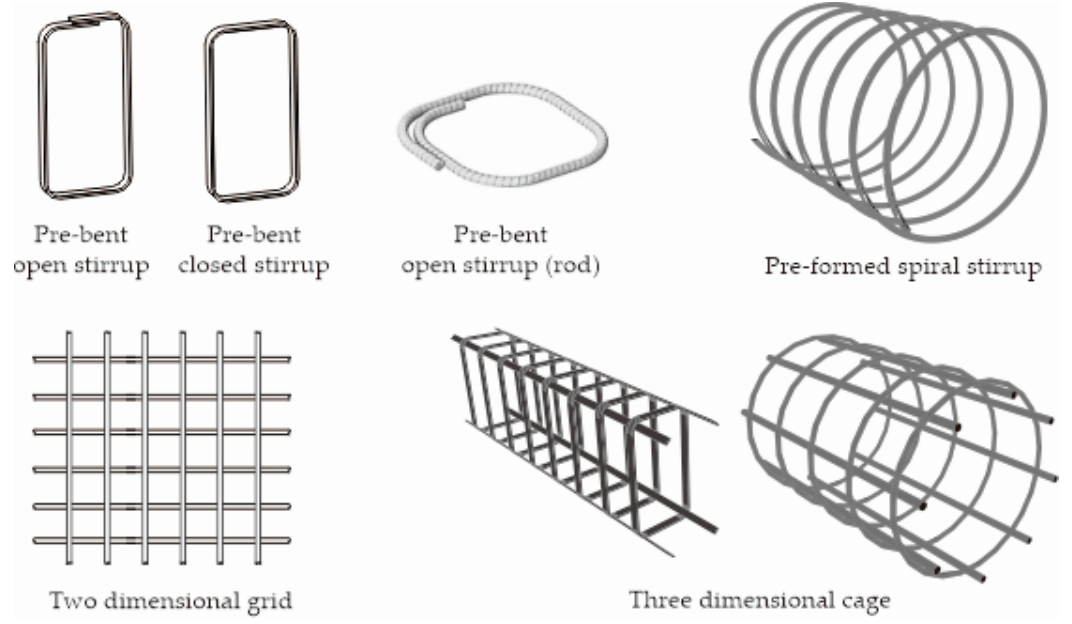
Figure 10. Various commercially available shaped FRP reinforcements (adopted from